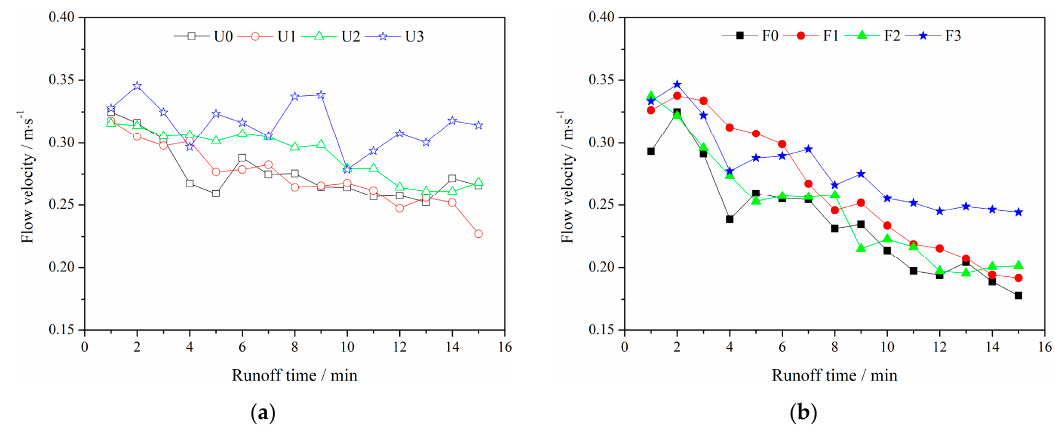
Figure 4. Variations in flow velocity under different treatments over time. ( a ) Unfrozen slope, ( b ) frozen slope. ( b ) frozen